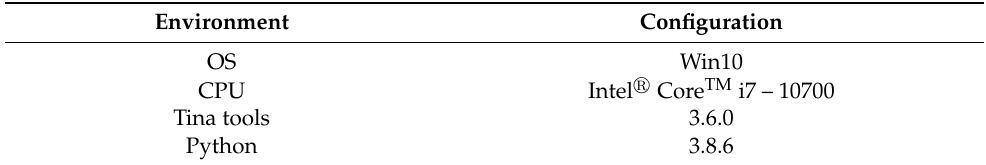
Table 6. The environment of the experiment. Environment